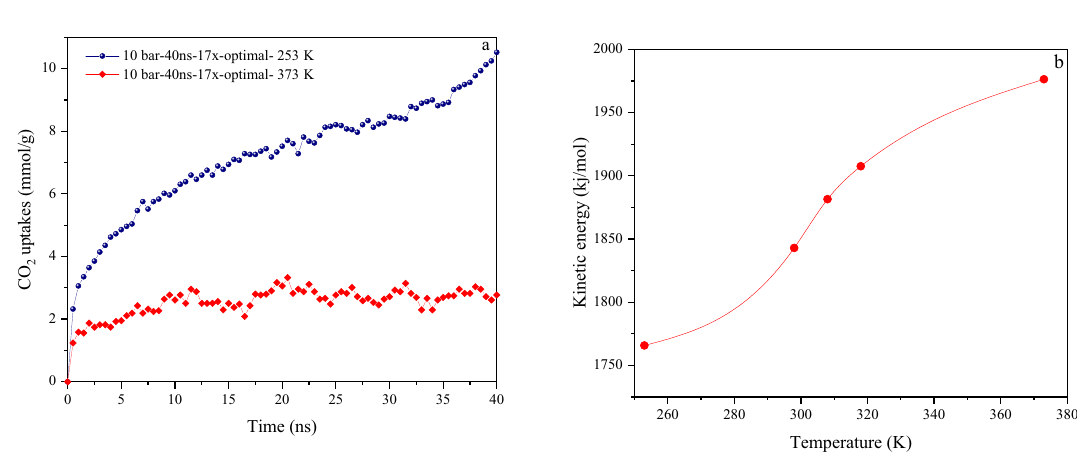
Figure 10. ( a ) CO 2 adsorption prediction at 253 K and 373 K under 10 bar; ( b ) The kinetic energy of CO 2 molecules in the range of 253–373 K